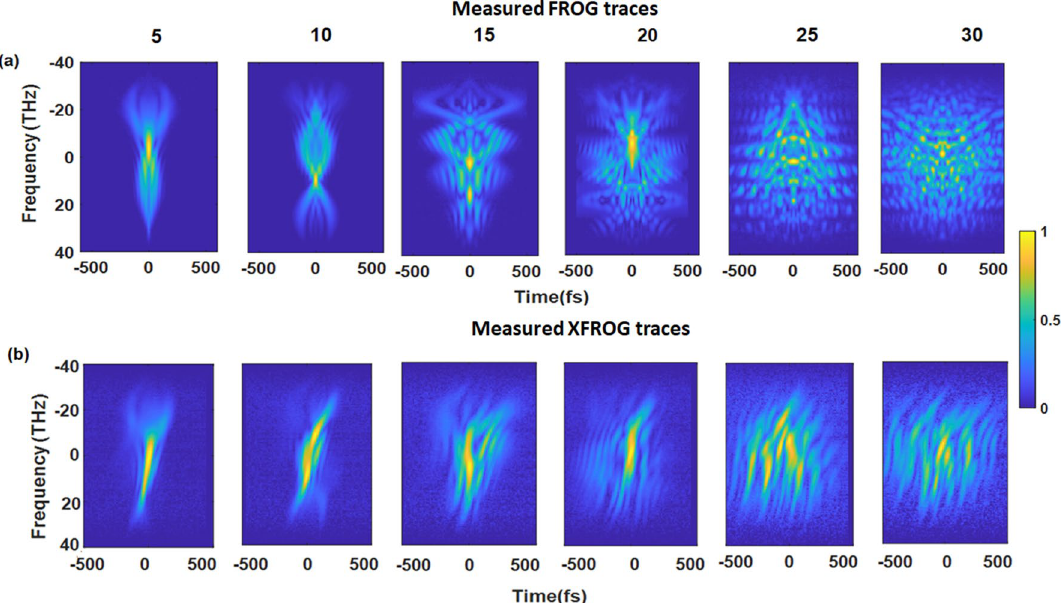
Figure 3. Normalized experimental ( a ) FROG and ( b ) XFROG traces (electric field amplitudes) of a pulse modified with a 4f-pulse shaper with SLM-adjusted phases. The traces were acquired for a set of random phases generated by the variation of the number of random guide points N r from 5 to 30. N = 256, T = 900, dt = 7.06 fs. Each trace was normalized to its maximum